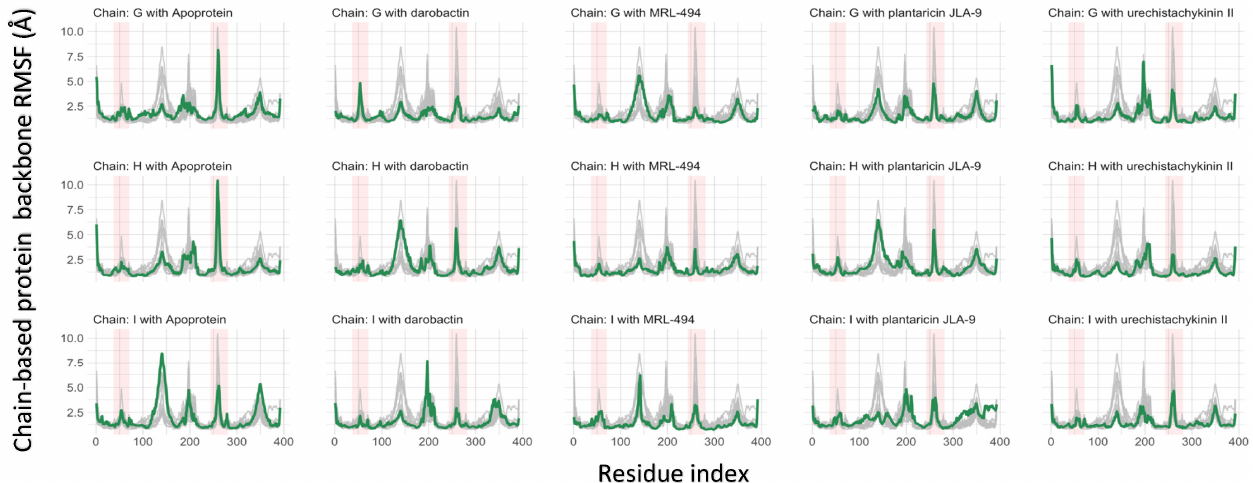
Figure 5. The RMSF of TolC protein. Backbone RMSFs are plotted separately (green) and compared with all the RMSFs, including apo-protein (gray) in the other plots. Active β -barrel sites of interest are highlighted in red. There are four β -sheets per chain, and each highlighted column represents two β -sheets.